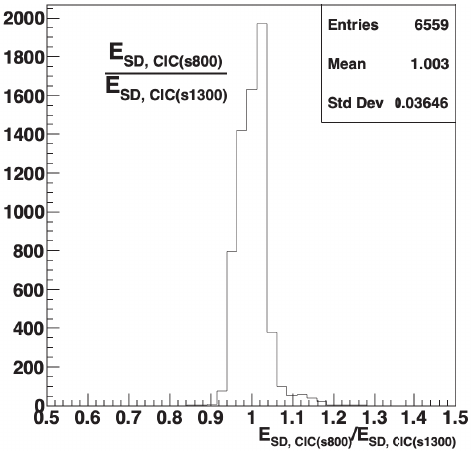
Figure 9. Comparison among the energies reconstructed starting from S (800) and S (1300).